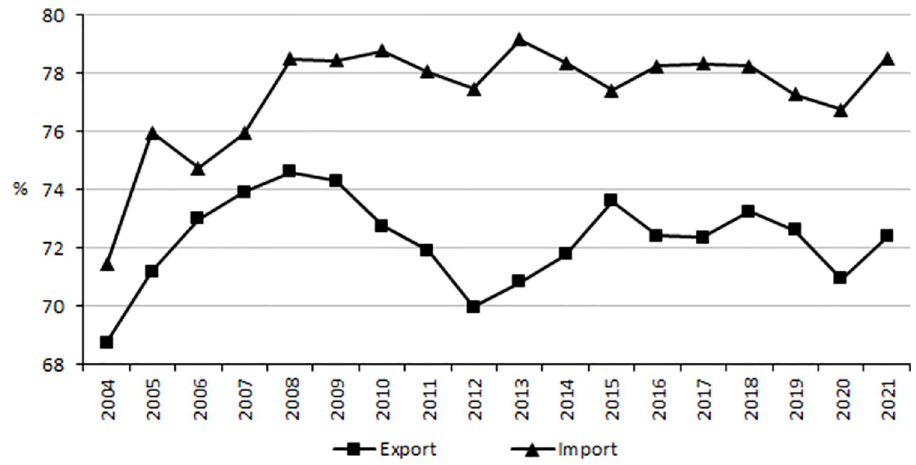
Fig 3. Share of intra-EU trade in agri-food products in total Poland’s trade in agri-food products in 2004–2021 (%). Source: [13], the authors’ elaboration.